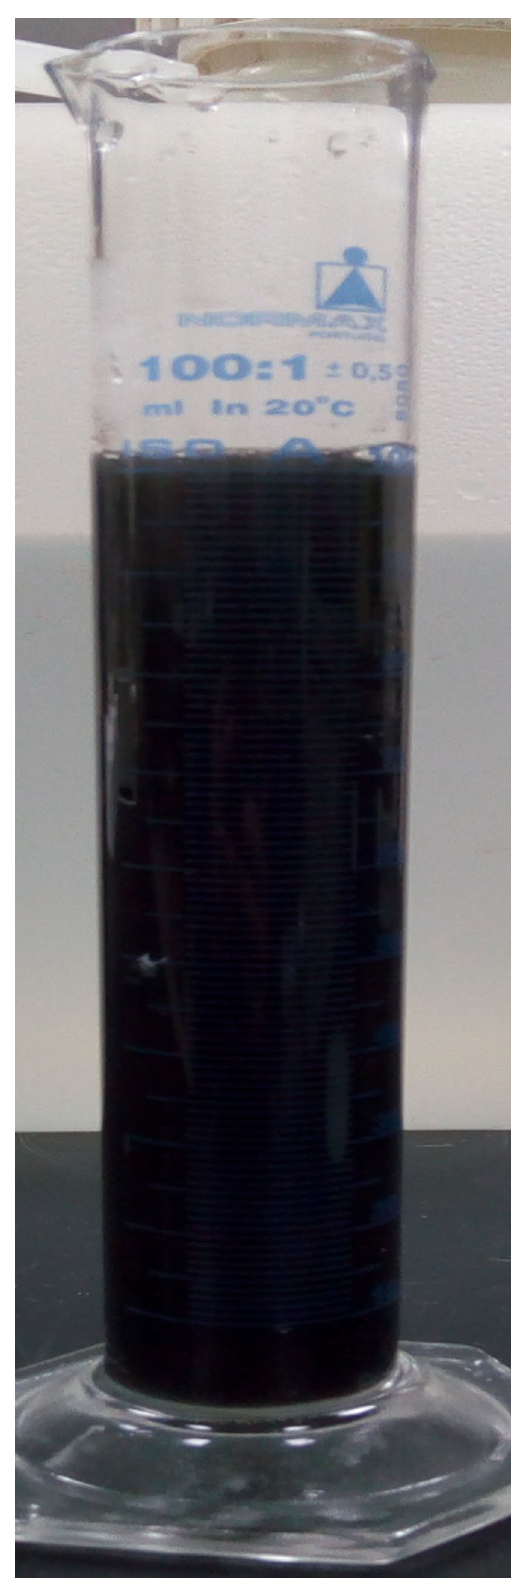
Fig. 1 Photograph of SMJ dark color